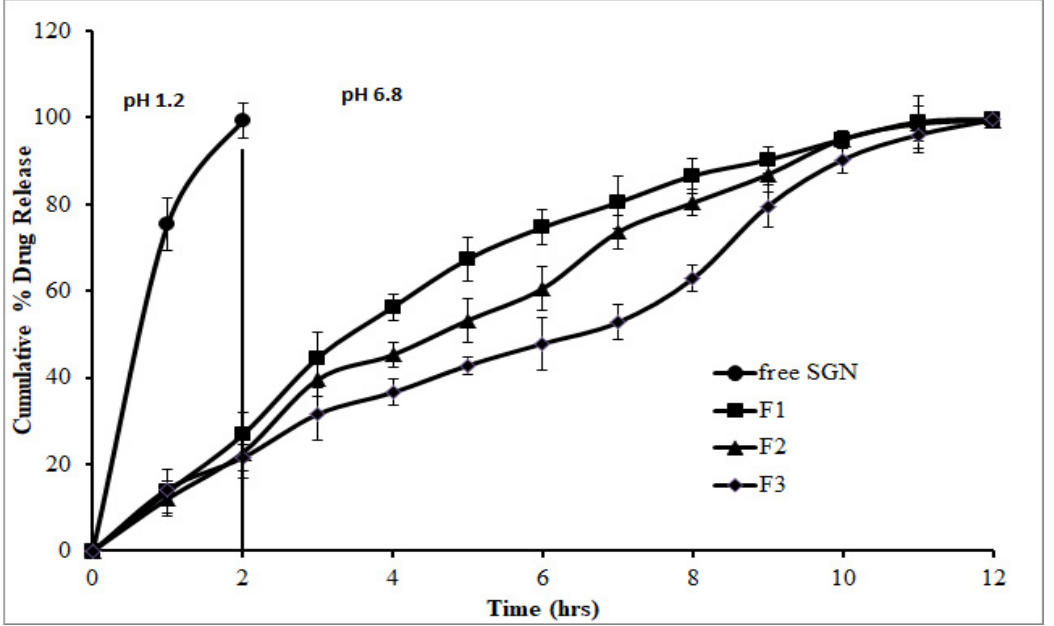
Figure 4. In vitro release of SGN from prepared SGN–TC nanoparticles.